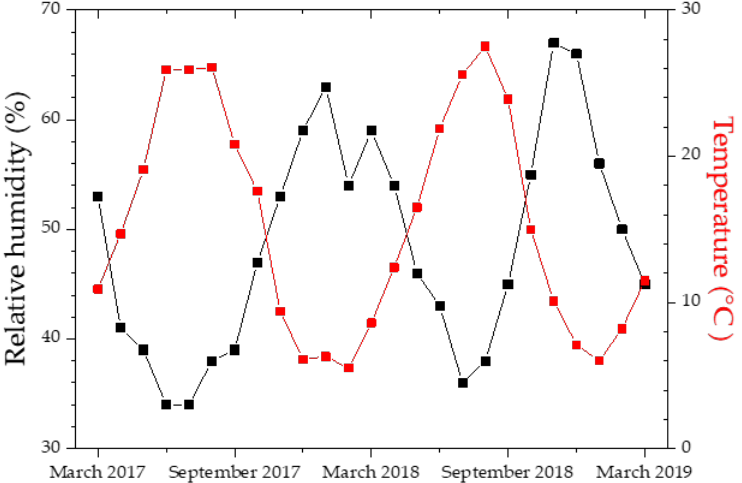
Figure 1. Average relative humidity and temperature of the atmosphere of Madrid during the exposure time. Data provided by the State Meteorological Agency.